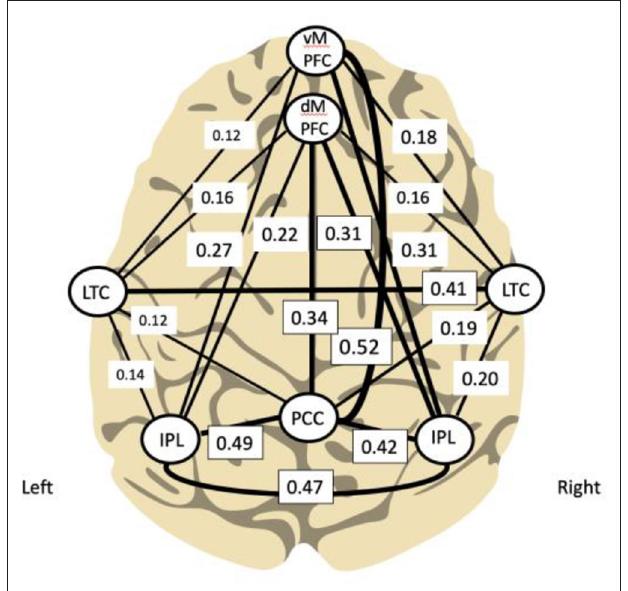
FIGURE 2 | Principal functional hubs and connectivity within default mode network ( Buckner et al., 2008; Other and Othmer, 2019) (modified). Density of connectivity is correlated with line